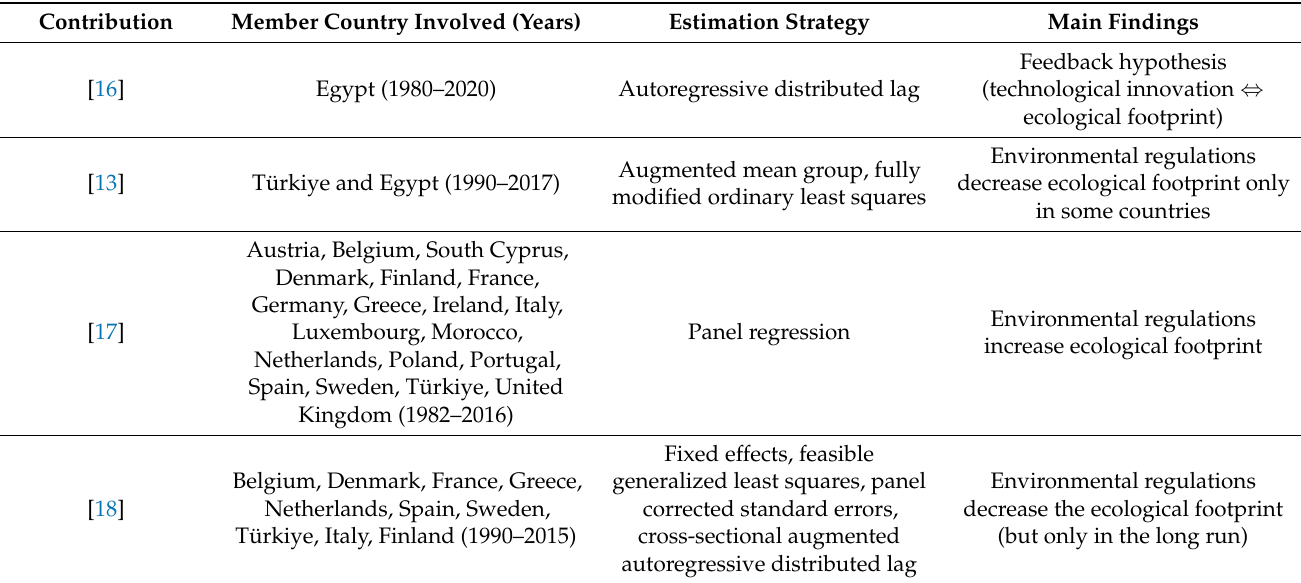
Table 1. Selected empirical literature involving Union for the Mediterranean member